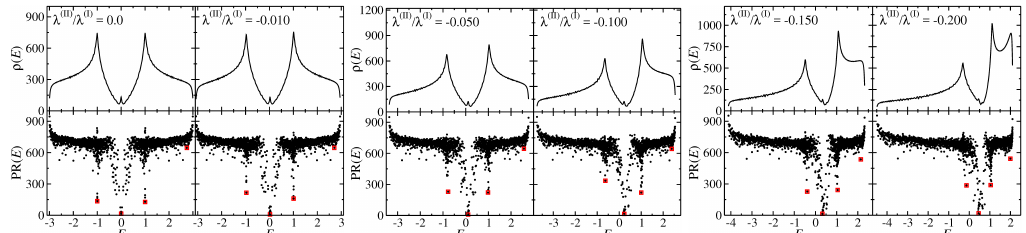
Figure 7. As in Figure 3, but for a hexagonal lattice with Africa shape consisting of 1979 sites. Red squares highlight the most localized states at the Dirac point (DP), the lower van Hove singularity vHs − , at the upper one (vHs + ) and at the upper band edge. The detailed λ ( II ) / λ ( I ) -dependence with λ ( I ) = 1 fixed and λ ( III ) = − λ ( II ) /2 of the PR loc for these four states will be the focus of Section 5. The results are similar for the hexagonal lattice with rectangular shape, and therefore are not shown.